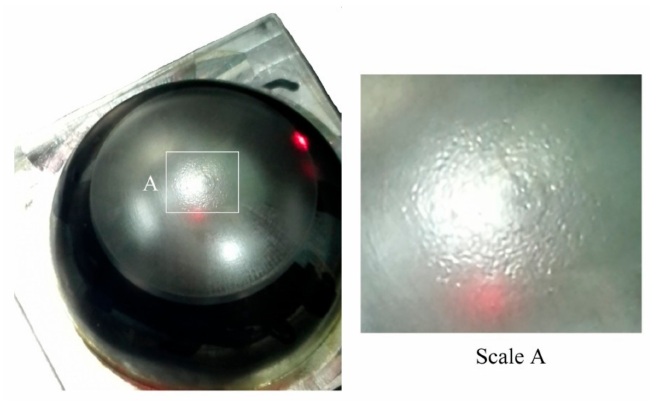
Figure 13. Vaporization occurred on the top of